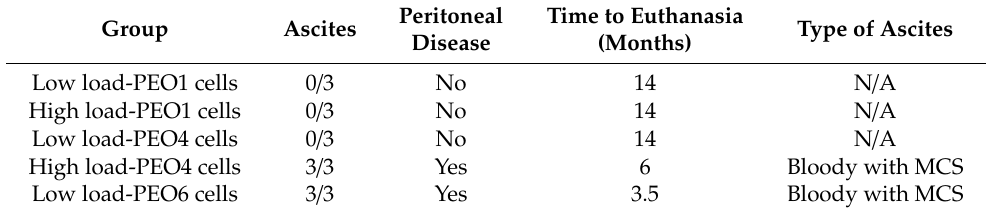
Peritoneal Time to Euthanasia Type of Ascites Disease (Months)